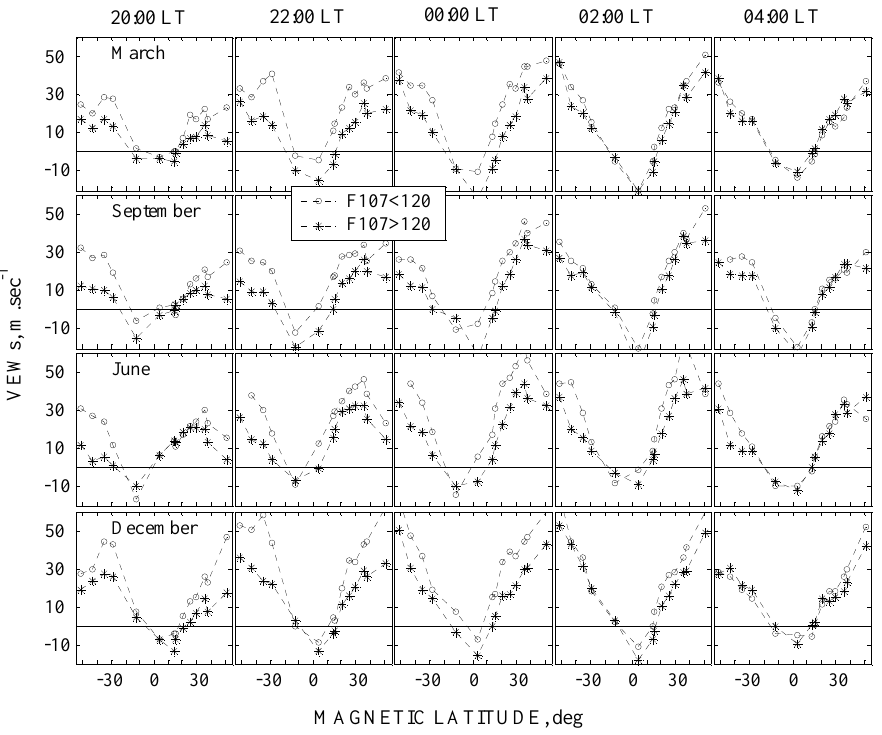
Fig. 3. Local time and solar activity variations of the vertical equivalent winds (VEWs) for all latitudes at night from 20:00 LT to 04:00 LT. The first to the last panels represent March equinox, September equinox, June solstice and December solstice, respectively. The lines with circles and asterisks present VEWs of solar minimum and solar maximum, respectively. Positive upward.